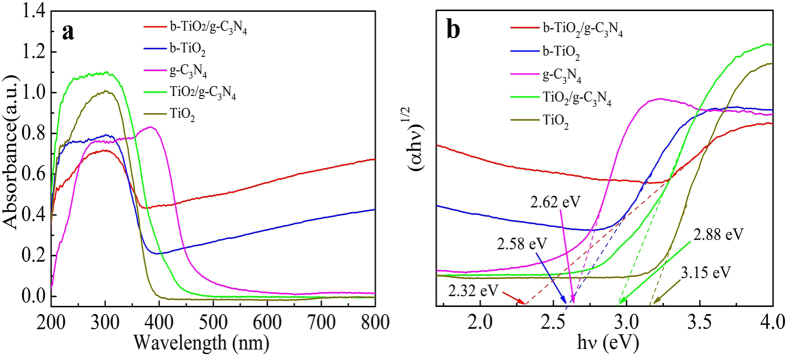
UV-visible diffuse reflectance spectra (a) and determination of the indirect interband transition energies (b) of TiO2, g-C3N4, TiO2/g-C3N4, b-TiO2 and b-TiO2/g-C3N4, respectively.